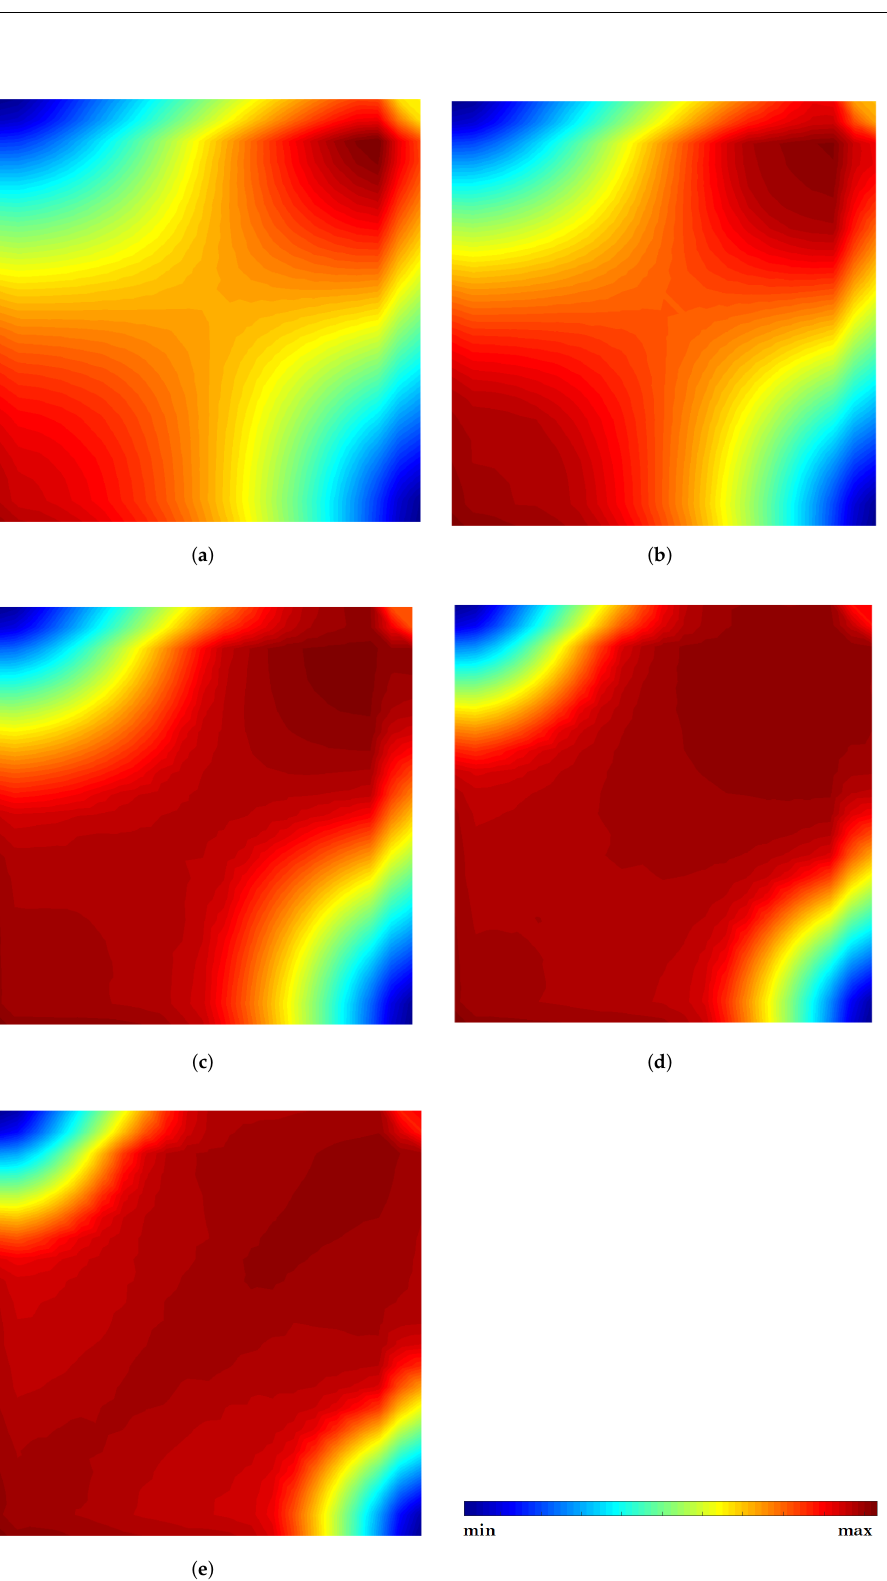
Figure 11. Effective von Mises stress distribution maps obtained with RPIM for five load increments considering the simply supported plate. For each load increment, the minimum and maximum effec- tive stresses are: ( a ) f = 807.13 KN/m 2 : σ min = 0 MPa; σ max = 170 MPa. ( b ) f = 988.79 KN/m 2 : σ min = 0 MPa; σ max = 205 MPa. ( c ) f = 1170.34 KN/m 2 : σ min = 0 MPa; σ max = 210 MPa. ( d ) f = 1351.95 KN/m 2 : σ min = 0 MPa; σ max = 215 MPa. ( e ) f = 1473.02 KN/m 2 : σ min = 0 MPa; σ max = 220